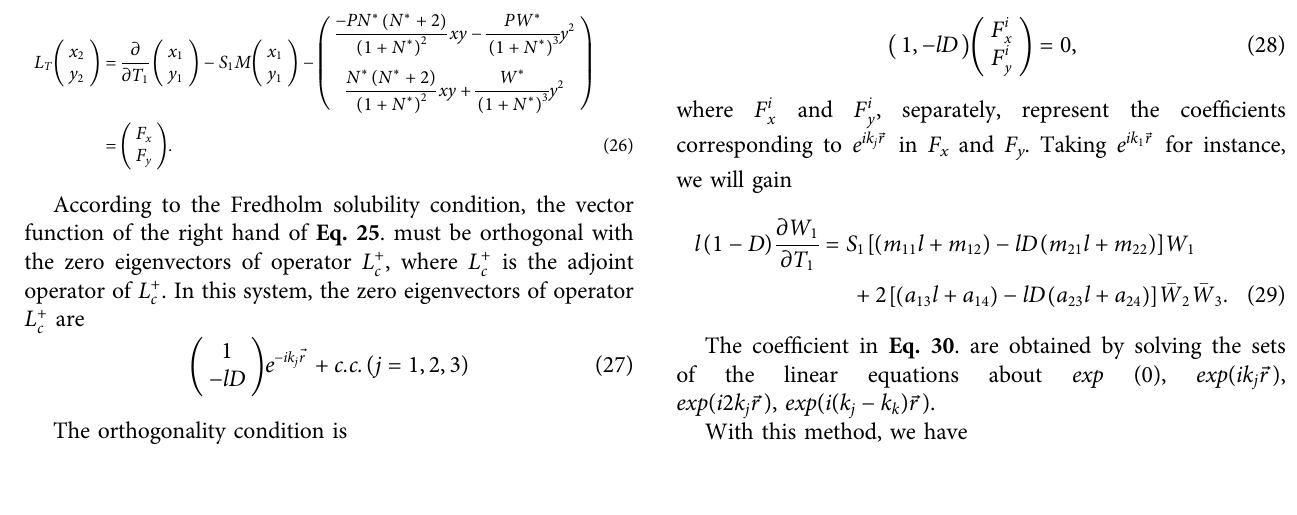
Frontiers in Physics |